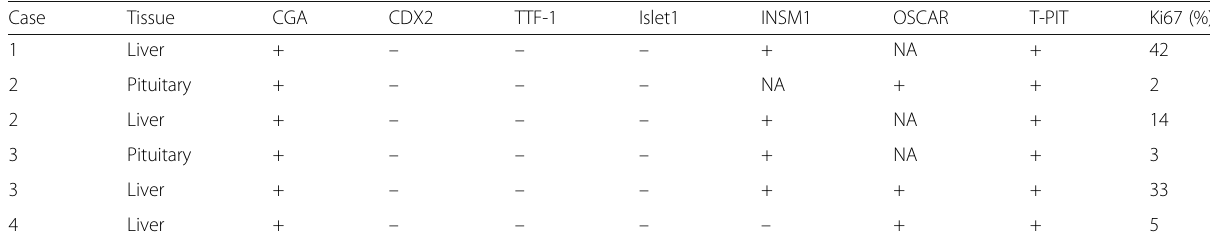
Table 2 The immunophenotype of the respective cases showing consistent expression of T-PIT and concordance between pituitary and liver